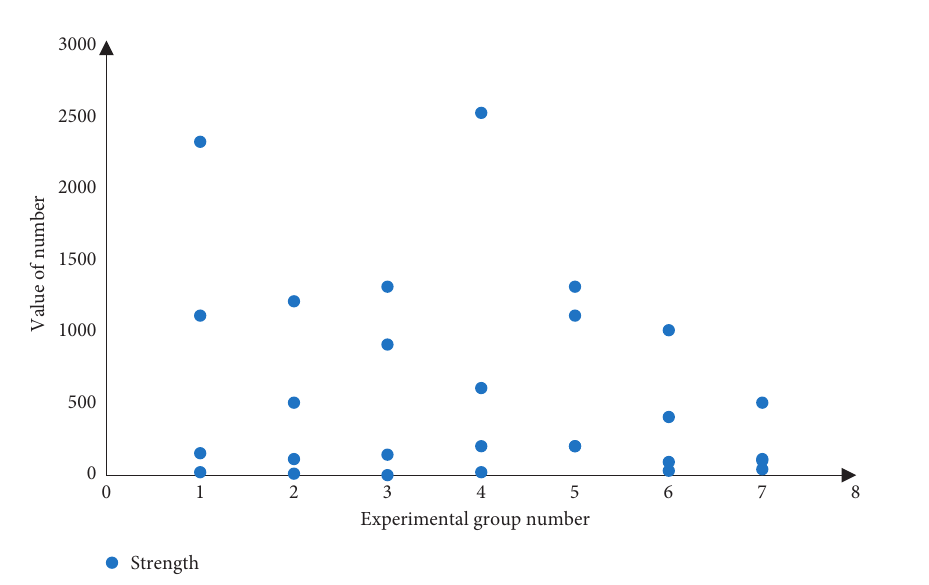
Figure 4: Repair effect of fiber-reinforced magnesium phosphate cement-based